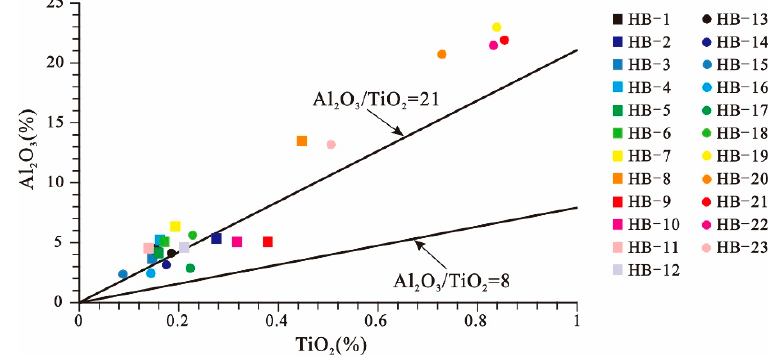
/ TiO Figure 14. Al 2 O 3 /TiO 2 ratios of the samples from the Hebi No. 6 mine. Figure 14. Al 2 O 3 2 ratios of the samples from the Hebi No. 6